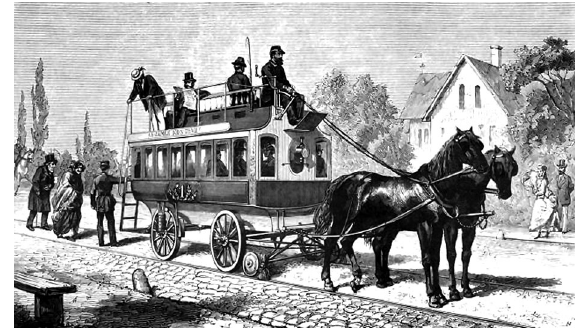
Fig. 1. The first horse-drawn coach (1872)